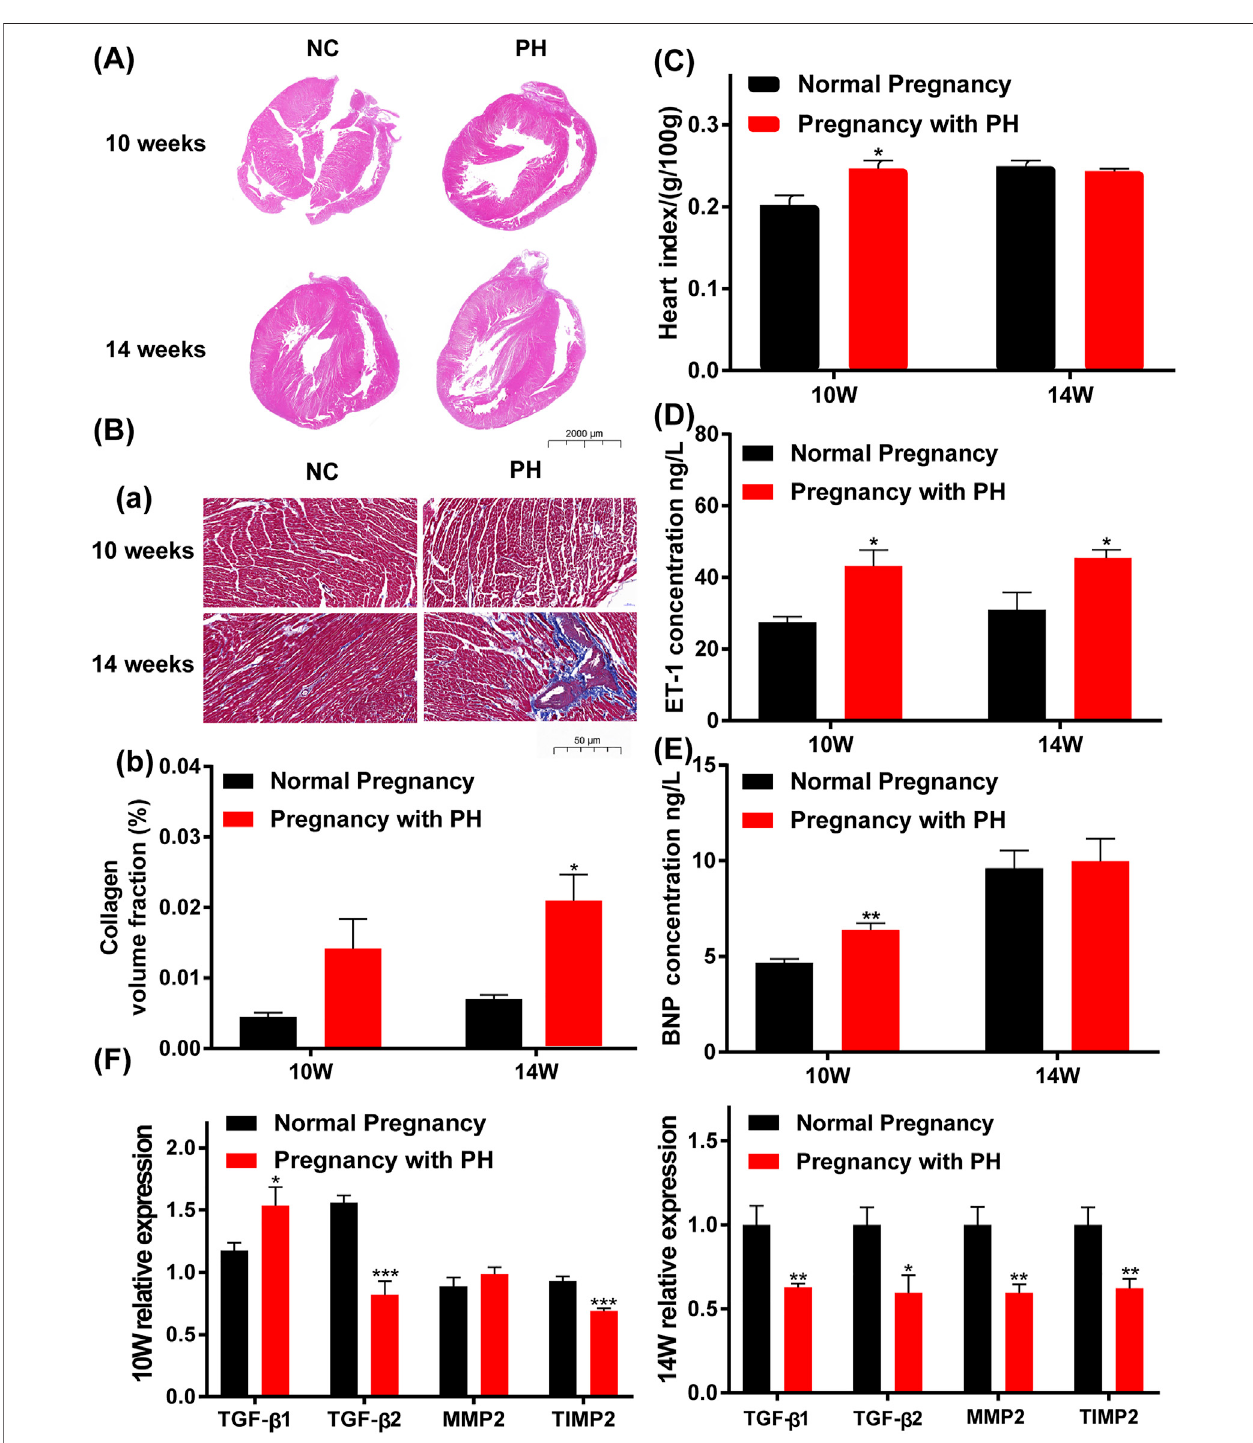
FIGURE 6 | Abnormal cardiac changes in adult rat offspring in the PH pregnancy group. (A) Representative H&E-stained hearts. (B) . (a) Representative Masson ’ s staining, Collagen fi bers are blue, and muscle fi bers are red. (b) Calculation of the collagen volume fraction. The large images show the entire heart (0.5 × magni fi cation). The barindicates 2000 μ m. Thesmall images showpart oftherightventricularwall(20 × magni fi cation).Thebar indicates 50 μ m. (C) Theheartindex (heart weight/body weight) of offspring at 10 weeks of age and 14 weeks of age in each group. (D) The expression of ET-1 in the plasma in each group at 10 weeks of age and 14 weeks of age was determined by ELISA. (E) The expression of BNP in the heart tissue in each group at 10 weeks of age and 14 weeks of age, as determined by ELISA. (F) ThemRNAexpressionofTGF- β 1,TGF- β 2,MMP2,andTIMP2inthehearttissueofoffspringineachgroupandateachage.* p < 0.05,** p < 0.01,*** p < 0.001 vs. the normal pregnancy group ( n (cid:1) 6 rats per group) NC, normal control; PH, pulmonary hypertension.